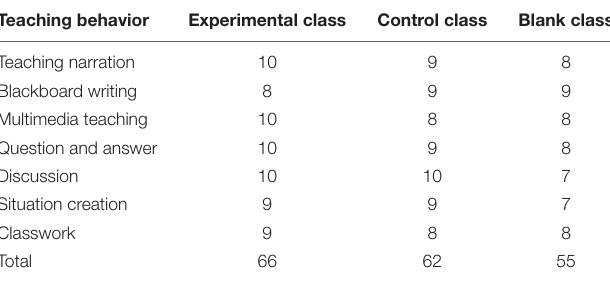
TABLE 1 | Effectiveness evaluation results of teachers’ teaching